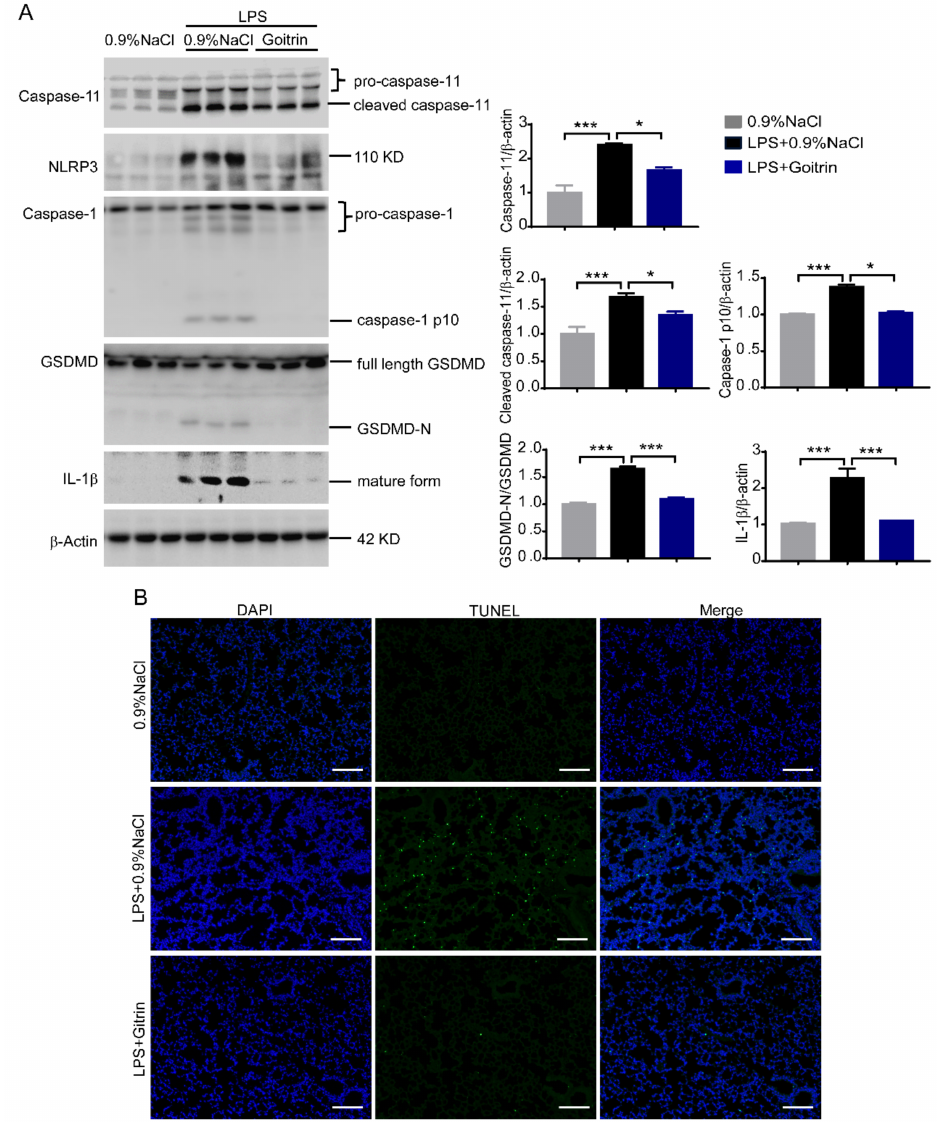
Figure 7. Goitrin prevented the activation of the caspase-11/GSDMD signal and pyroptosis. Mice were peritoneally injected with 0.9% NaCl or goitrin (30 mg/kg) 1 h before LPS (20 mg/kg) intra- venous injection and the mice were sacrificed 8 h later. ( A ) Protein levels of caspase-11, cleaved caspase-11, cleaved GSDMD (GSDMD-N), NLRP3, caspase-1, and mature IL-1 β were analyzed in lung tissues ( n = 3). ( B ) DNA breakage was assayed by the TUNEL method in lung tissues ( n = 6). The data are presented as the means ± SD. * p < 0.05, *** p < 0.001 (ANOVA LSD test). (scale bar = 50 µ